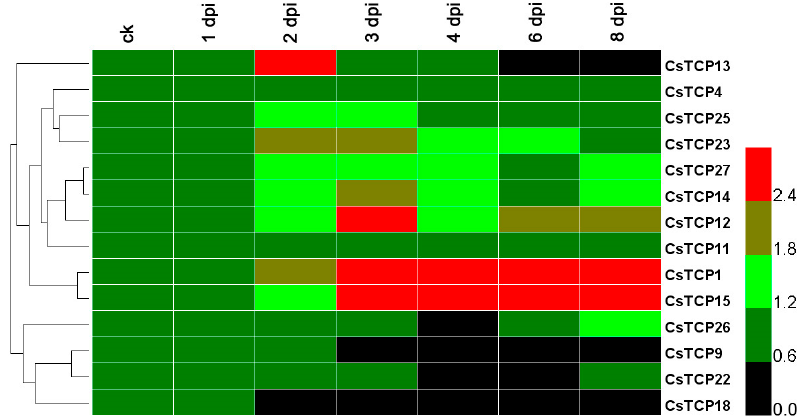
Figure 3. Responsive analysis of CsTCP genes under downy mildew stress. The CsTCP genes transcripts were determined from day post inoculation 1 to 8 after DM treatment, compared with in the control (CK) without inoculation. The color scale shows that the increasing expression levels form black to red.